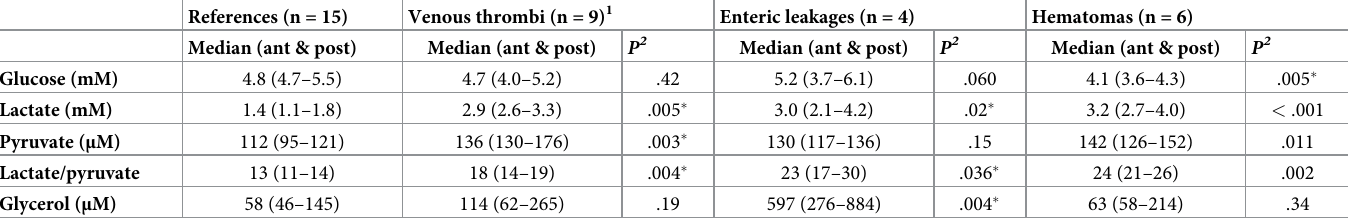
Table 3. Microdialysis values from the entire observational period (median (quartiles)) from catheters placed anteriorly and posteriorly of 34 consecutive pancreas